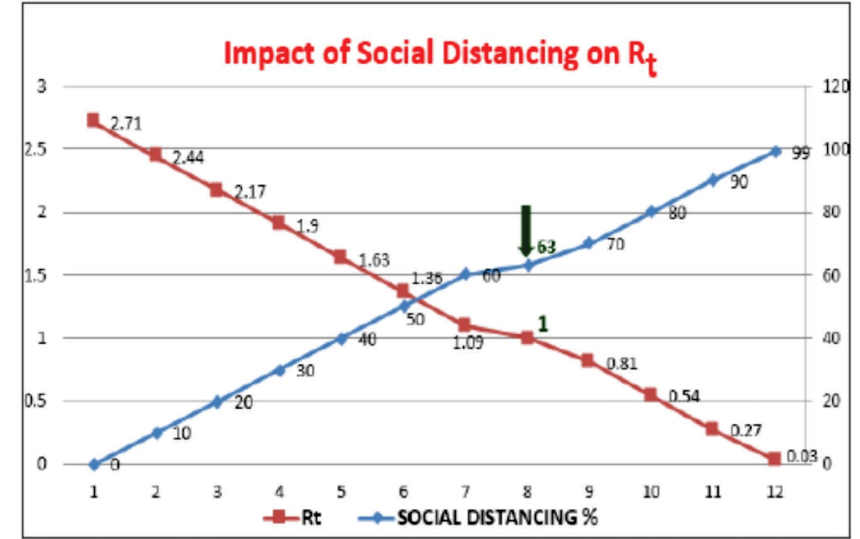
Figure 2: Impact of social distancing on reproduction rate